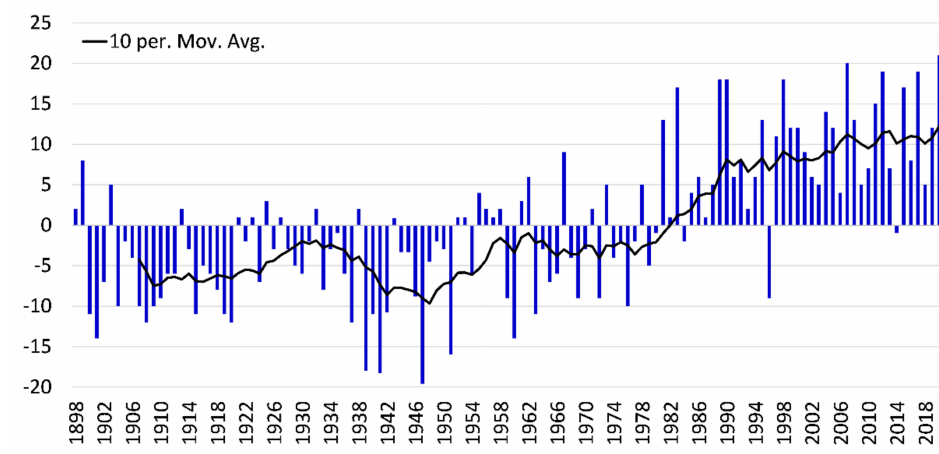
Figure 4. Anomalies of average annual Baltic Sea level in Klaip˙eda, cm.